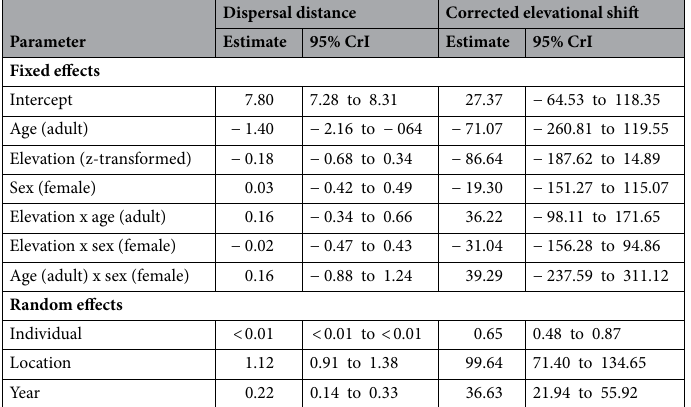
Table 3. Parameter estimates of the linear mixed models investigating factors affecting dispersal distance and elevational shift of dispersal. The lower and upper limits of the 95% credible intervals are based on Monte Carlo simulation of the posterior distribution. For the random effects the among-group standard deviation is given. N = 56 dispersal events of 51 individuals from 26